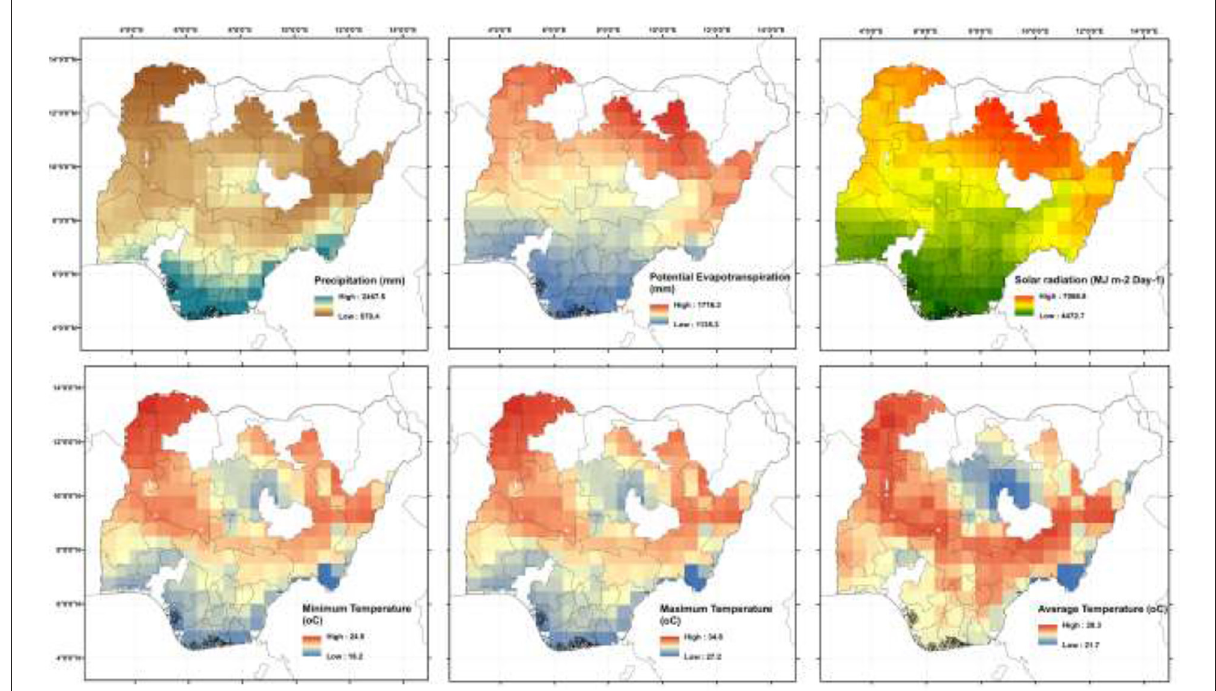
FIGURE1 Longitudinal and latitudinal gradients of long-term mean values of precipitation, potential evapotranspiration, solar radiation, minimum temperature, maximum temperature, and the mean temperature during the growing season of cassava from 1995 to 2019 in 30 states of